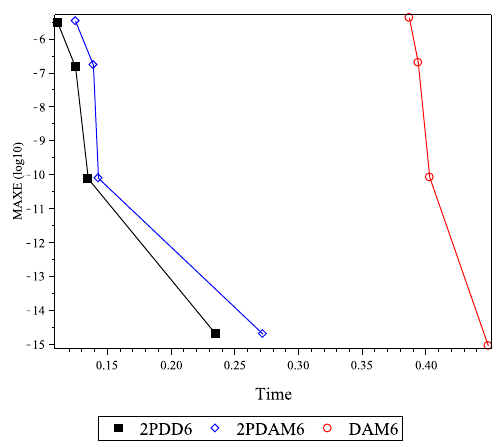
Figure 6. Performance graphs of time vs. log MAXE for Problem 3.